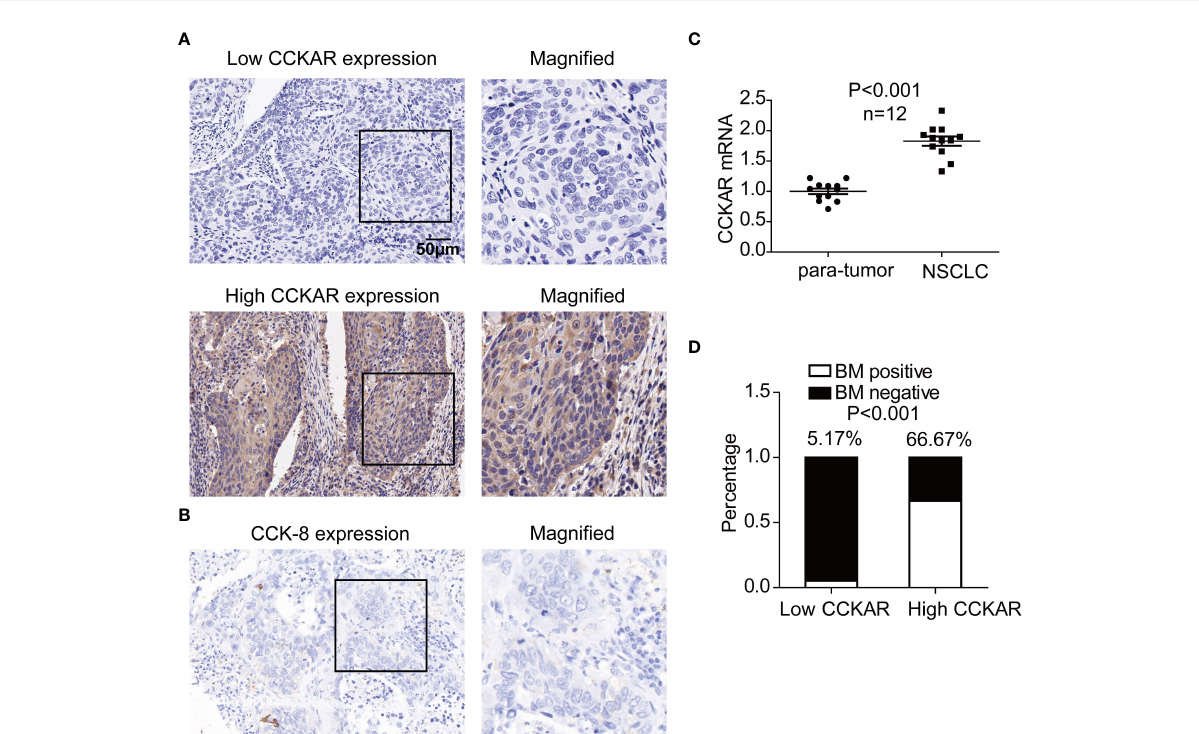
FIGURE 1 Expression of CCKAR in NSCLC. (A) The expression of CCKAR in NSCLC was detected by IHC. Patients with NSCLC were divided into subsets with low or high CCKAR expression. (B) Expression of CCK-8 in NSCLC was detected with IHC and representative images were shown. (C) CCKAR expression in 12 pairs of NSCLC and para-tumor tissues was detected with qRT-PCR. The statistical signi fi cance was evaluated by paired t test. (D) Asynchronous BM percentages of patients with low and high CCKAR were calculated and compared with chi-square method. Patients with high CCKAR in NSCLC primary tumor were much more susceptible to